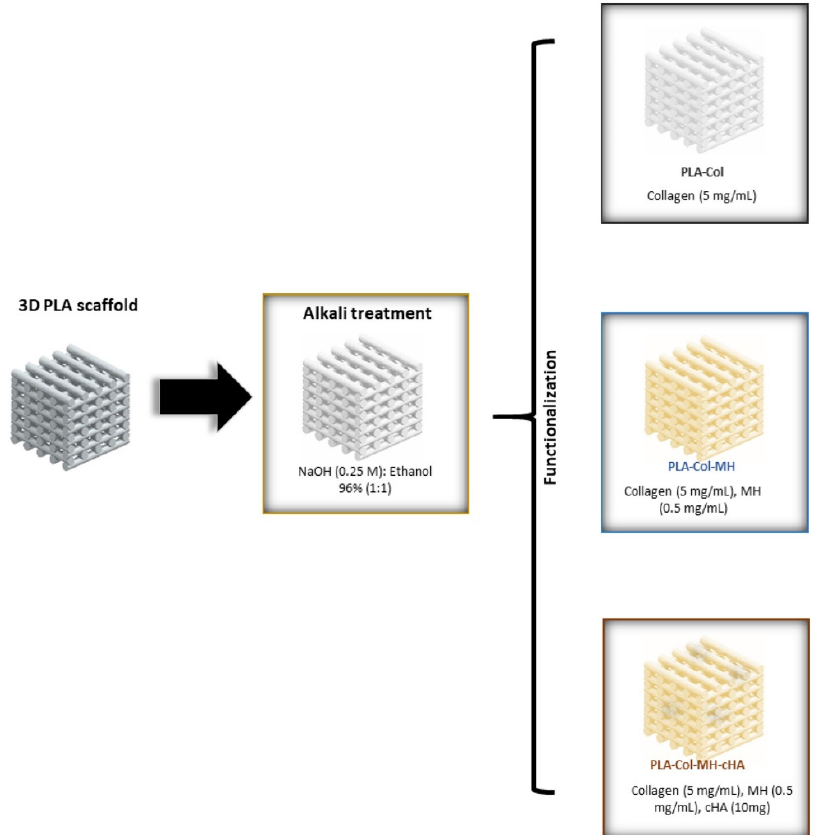
Figure 7. Schematic diagram of the experimental procedure for the multifunctionalization of the scaffolds after 3D-printing by using a simple coating process (PLA: polylactide; MH: minocycline hydrochloride; cHA: citrate-hydroxyapatite nanoparticles). Reprinted from [98] with permission from